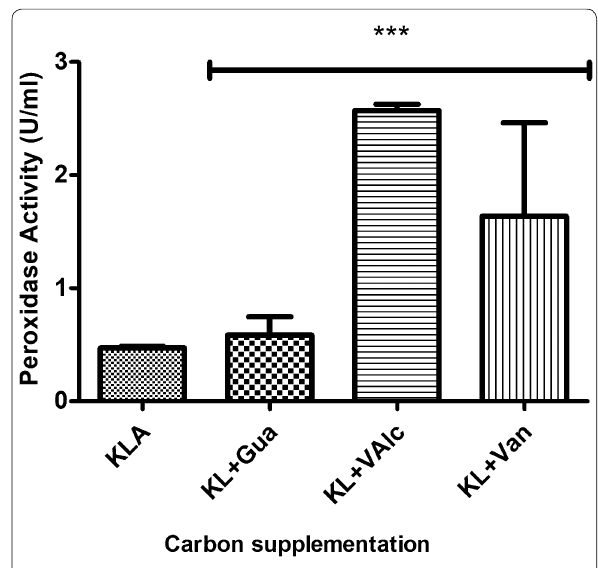
Fig. 3 Agitation speed for optimum peroxidase activity expression Fig. 4 Influence of lignols on peroxidase activity expression by by BMAB-1. Each column signifies mean SD. ***Significantly BMAB-1. Each column signifies mean SD. ***Significantly different ± ± different ( p < 0.05) from the static condition (0 rpm) while *not ( p < 0.05) from the control ( KLA kraft lignin alone). KL kraft lignin; Gua significantly different ( p > 0.05) from the static condition guaiacol; VAlc veratryl alcohol; Van